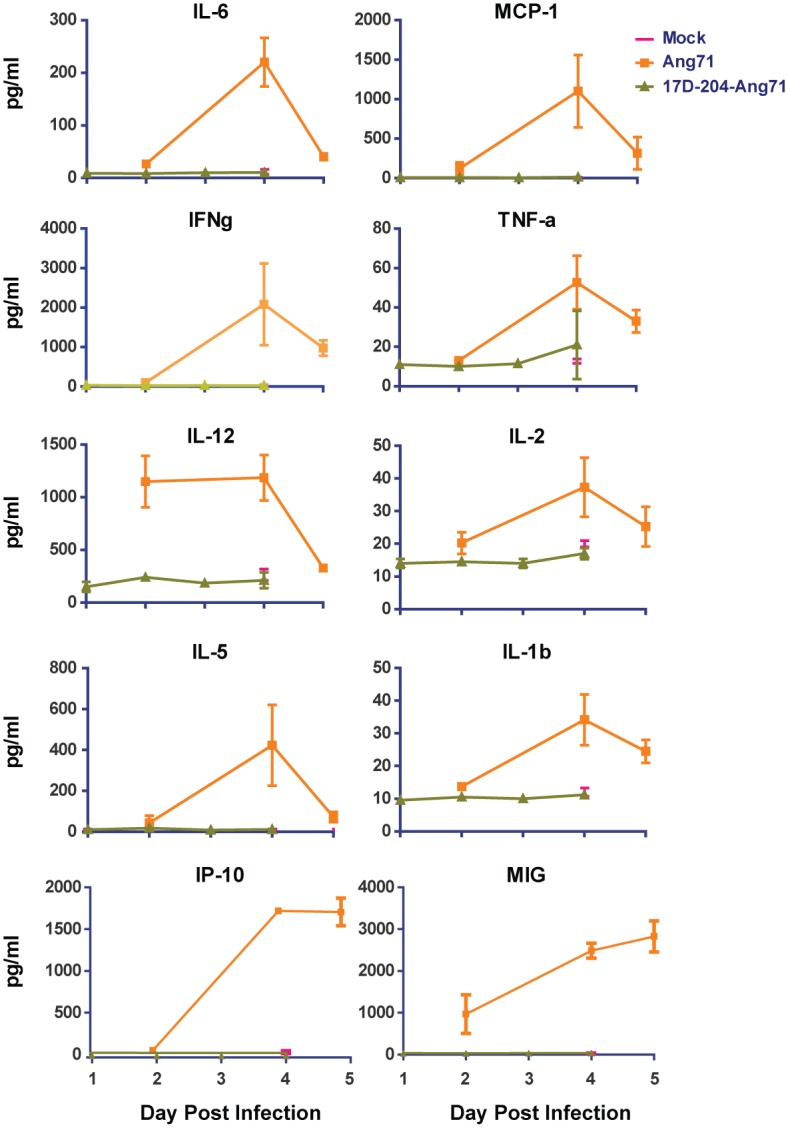
Immunization with 17D-204 protects mice against cytokine storm associated with virulent wtYFV infection.5–6 week old mice received 17D-204 immunization or mock vaccination. Mice in the groups receiving Ang71 were infected on d21 after 17D-204 immunization, at approximately 8–9 weeks of age. On the indicated days p.i., serum was harvested and cytokine levels were determined by multiplex Luminex bead assay. Mock groups were collected at a 4d p.i. only. Samples for the Ang71 group were collected on d2, d4, and d5 p.i. Samples for the 17D-204-Ang71 group were collected on d1, d2, d3, and d4 p.i. Samples were collected from three separate experiments. Displayed data are n = 5 for mock, n = 3 for the other groups.